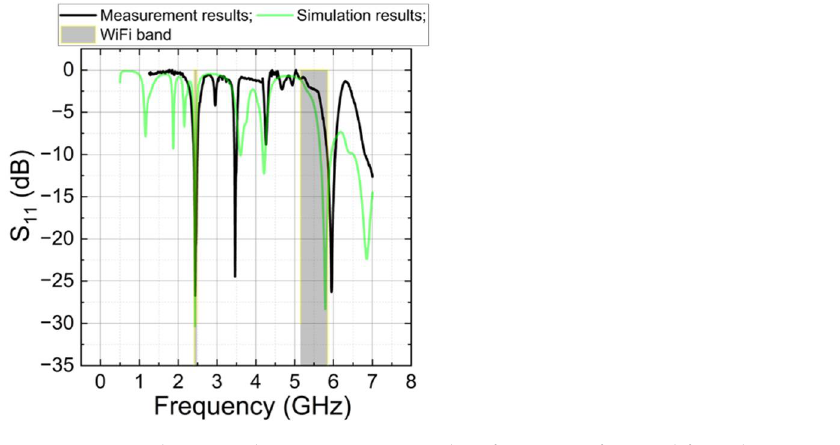
Figure 11. Simulation and measurement results of S 11 manufactured fractal antenna.